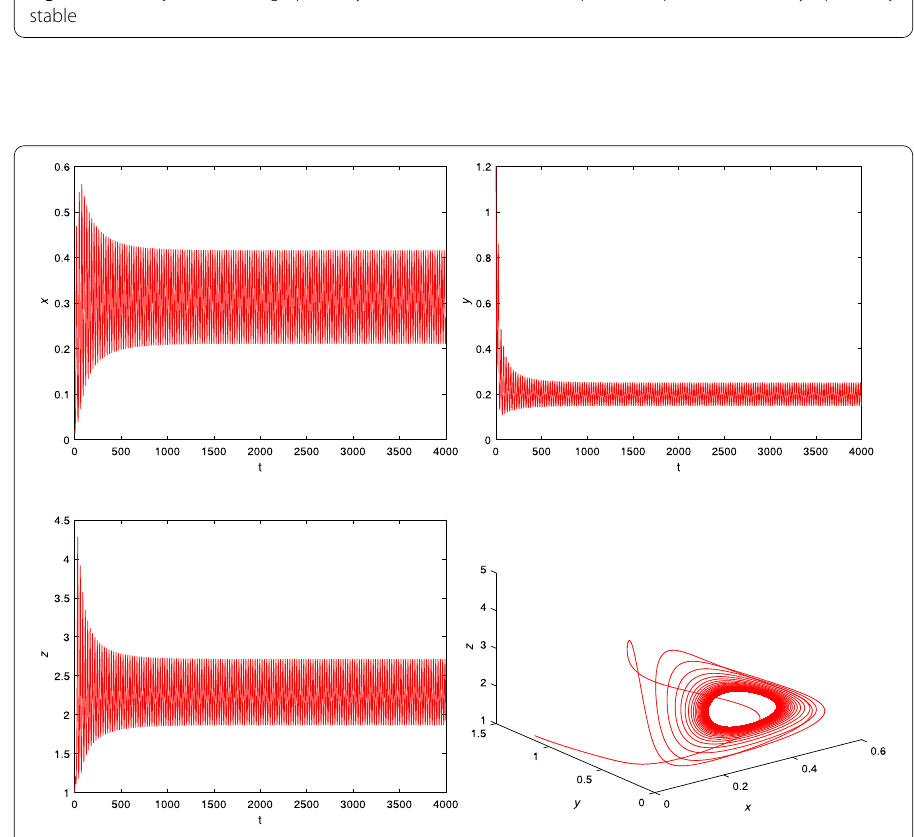
Figure 5 The trajectories and graphs of system (4.1) with τ = 16. The positive equilibrium E + is unstable, and a stable periodic solution from E